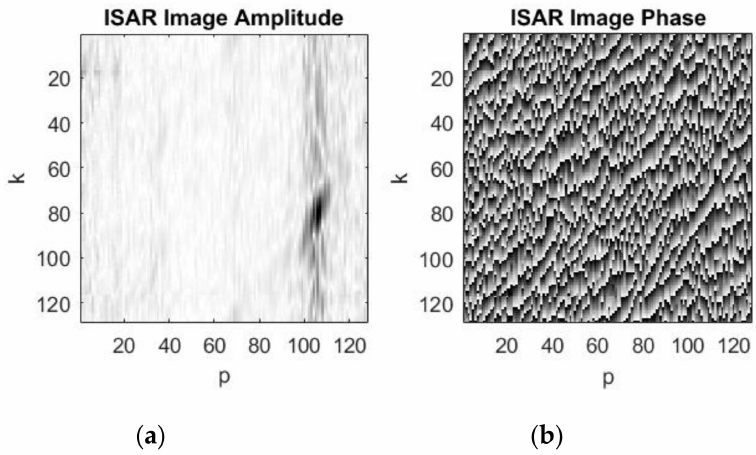
Figure 11. Resulting complex image after 10th additive summation of complex images: ( a ) ISAR image amplitude; ( b ) ISAR image